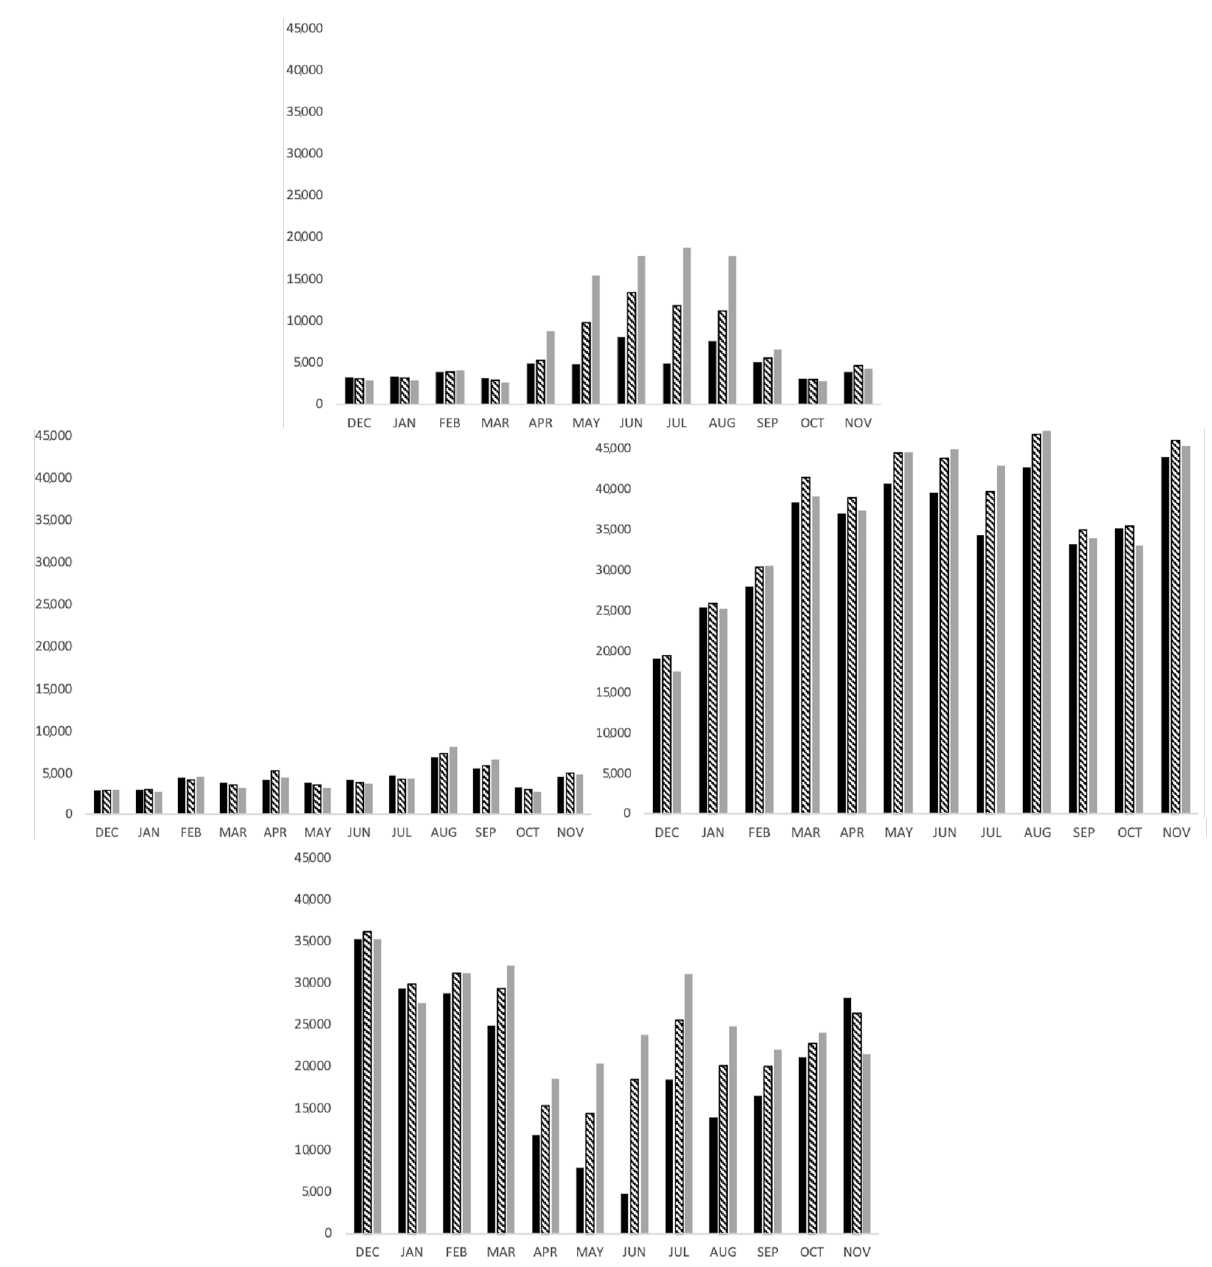
Figure 2. Irradiances from 380 to 780 nm (µW/cm 2 ) measured depending on the season (from December 2018 to November 2019); orientation of north ( top ), east ( right ), south ( bottom ), and west ( left ); and elevation from the horizontal level of 15° (black), 30° (striped), and 45° (grey).